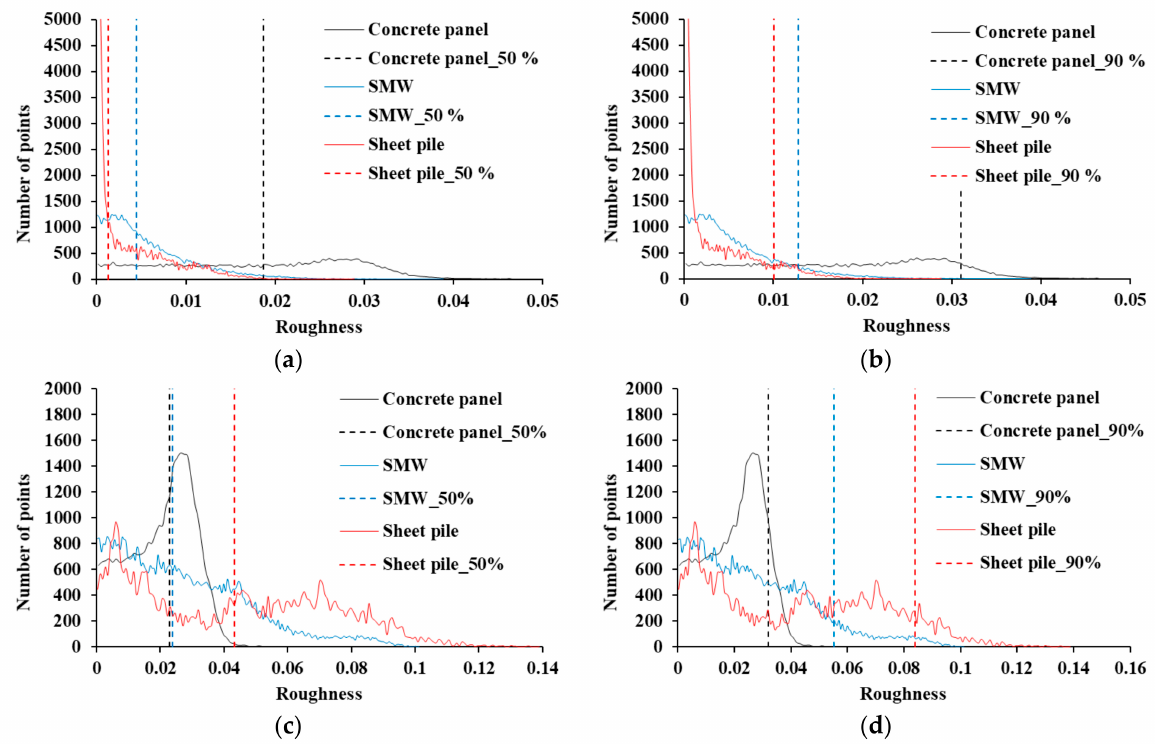
Figure 8. Local roughness and global curvature, ( a ) 50% of points (r = 0.1 m), ( b ) 90% of points (r = 0.1 m), ( c ) 50% of points (r = 0.5 m), ( d ) 90% of points (r = 0.5